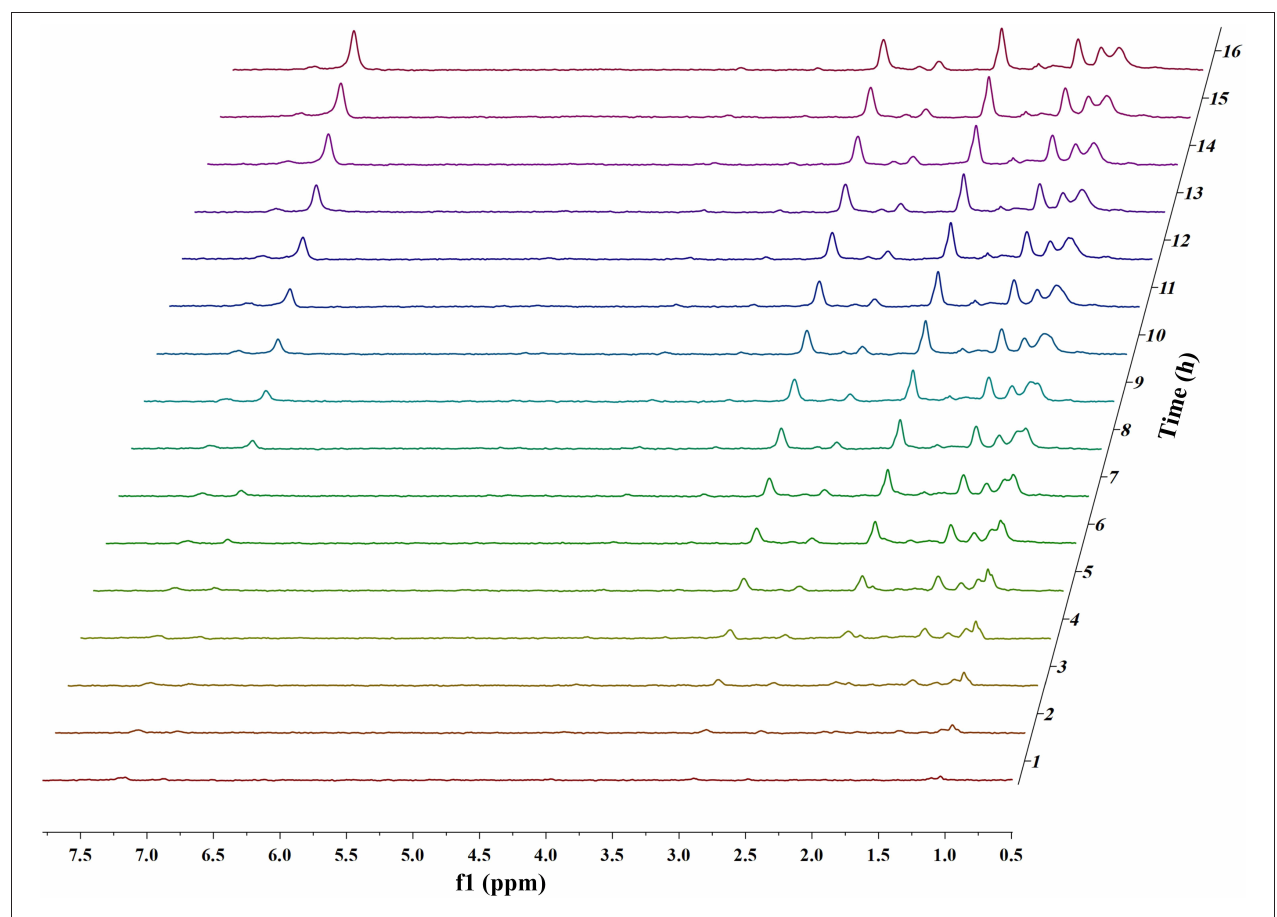
FIGURE 1 | In situ 2 H NMR monitoring of the deuterium traced upgrading reaction of PPE on Pd/ γ -Al 2 O 3 (5 wt%).